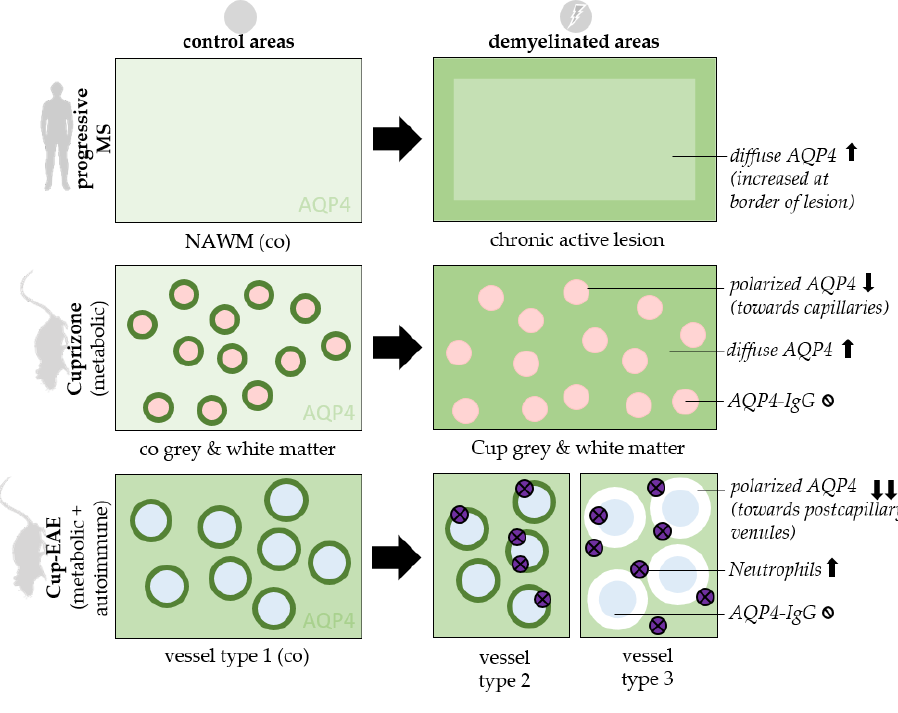
Figure 5. Synopsis of findings. AQP4 staining patterns are displayed in control areas ( left ) and demyelinated areas ( right ). 3 experimental settings are shown: Chronic active lesions of progressive MS patients ( top row ), mice treated with 5 weeks Cuprizone intoxication ( middle row ) and mice treated with Cuprizone + EAE ( bottom row ). Ø = absent, ↑ = increased, ↓ = reduced, co = control, cup = cuprizone, NAWM = normal appearing white matter, red circles = capillaries, blue circles = postcapillary venules.